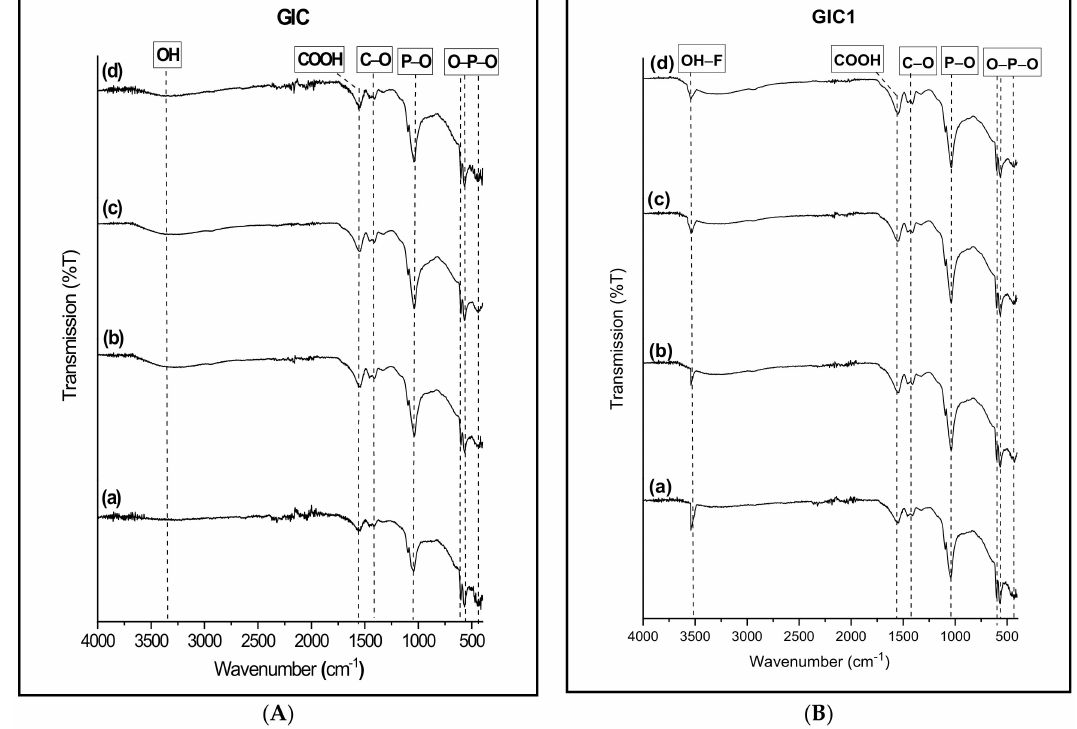
Figure 4. FTIR pattern of GIC ( A ) and GIC1 ( B ) sample for (a) 1 day, (b) 7 days, (c) 14 days, and (d) 21 days of ageing